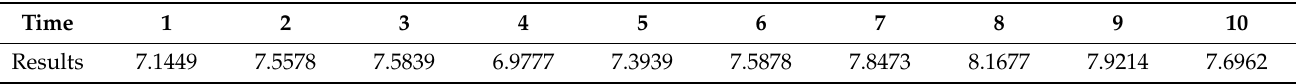
Table 1. Formula (6) k value